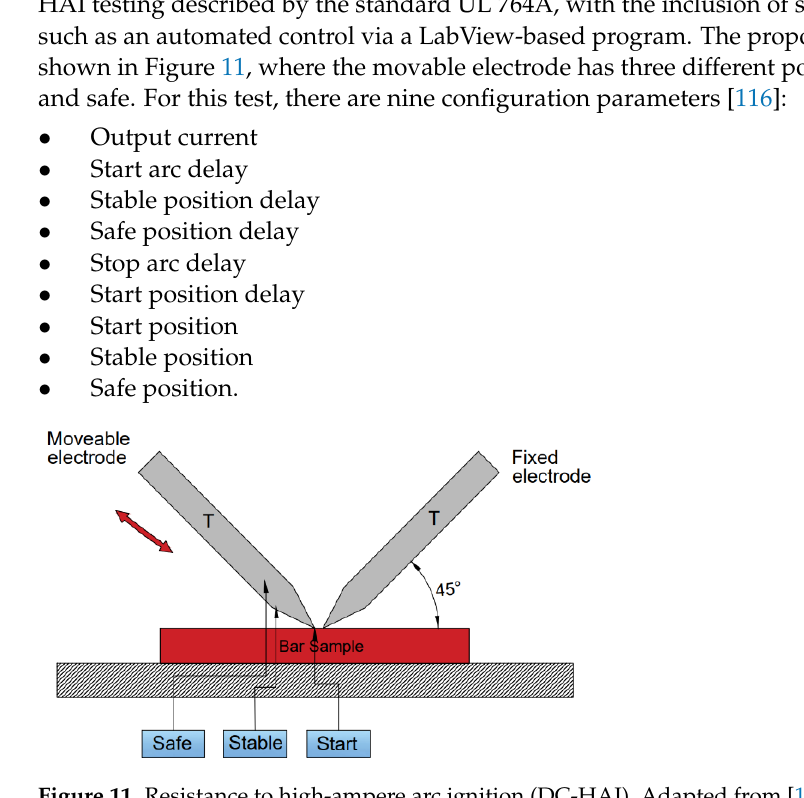
Figure 11. Resistance to high-ampere arc ignition (DC-HAI). Adapted from [117].